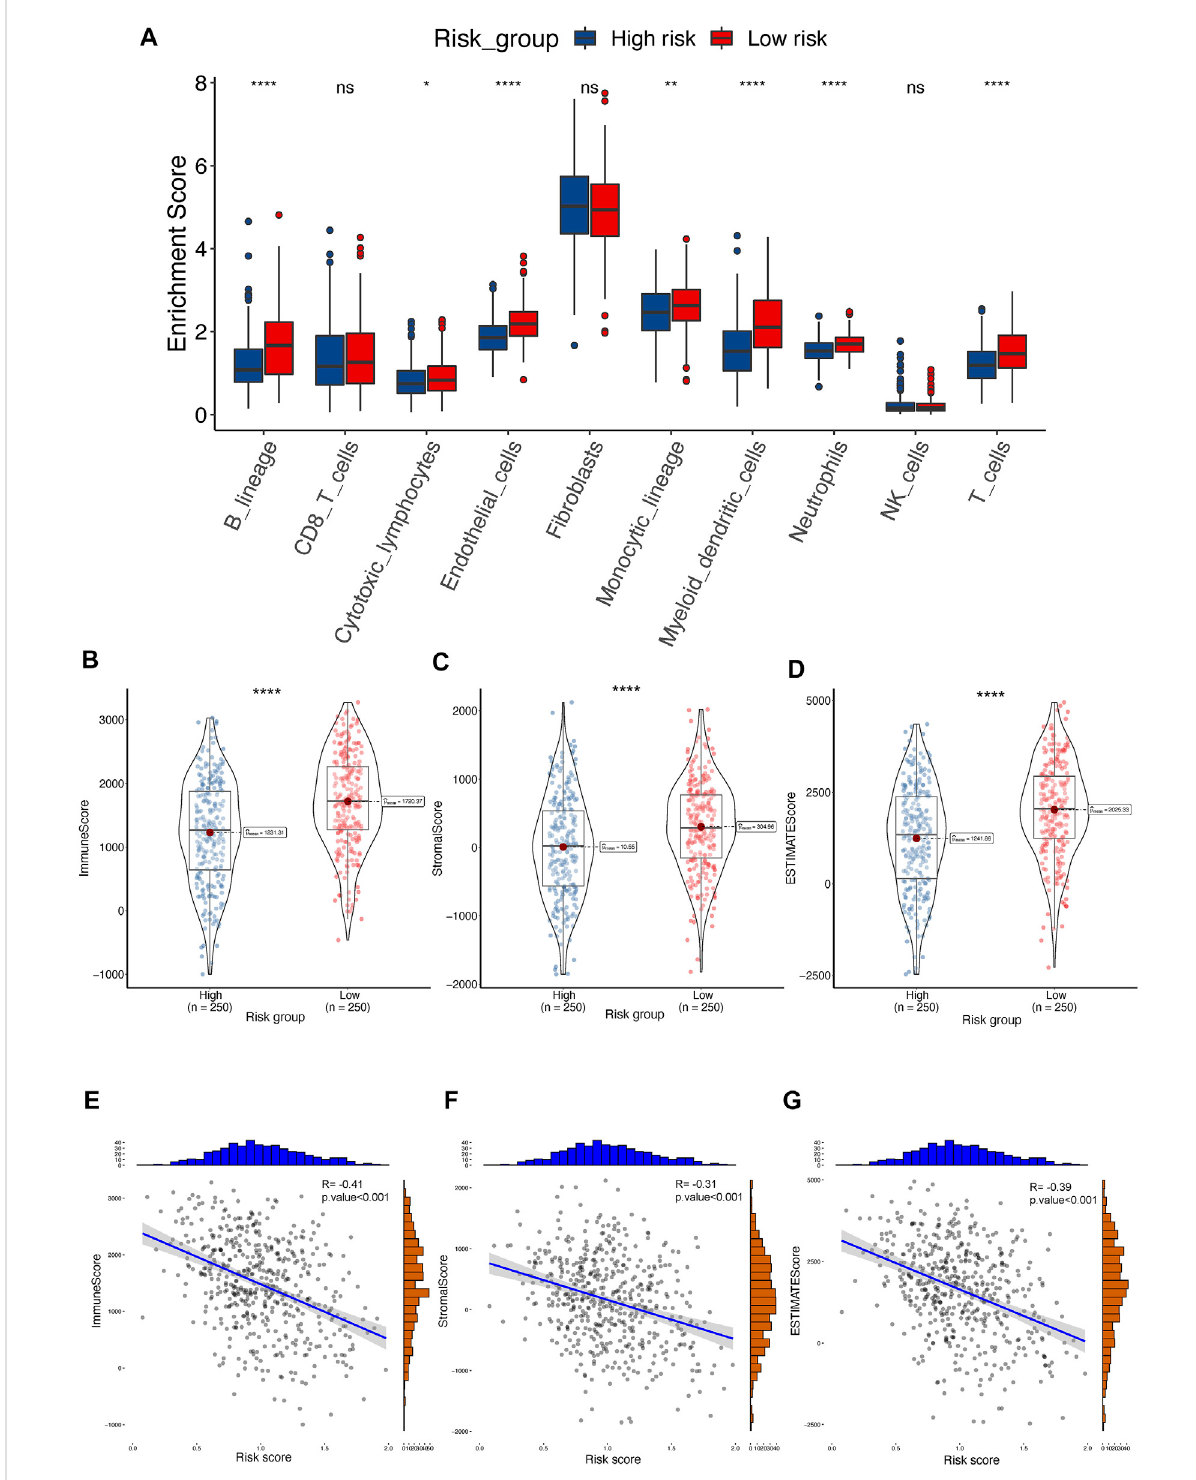
FIGURE 8 The landscape of TME between high- and low-risk groups in TCGA-LUAD cohort. (A) Distribution of T cell between TPR signature in TCGA- LUAD. (B – D) ESTIMATE tumor purity algorithm was utilized to calculate an immune score (B) , stromal score (C) , and tumor purity (D) of risk-related patients in the TCGA-LUAD cohort. (E – G) Pearson correlation analyses between risk score and immune score (E) , stromal score (F) , and estimate score (G) in the TCGA-LUAD